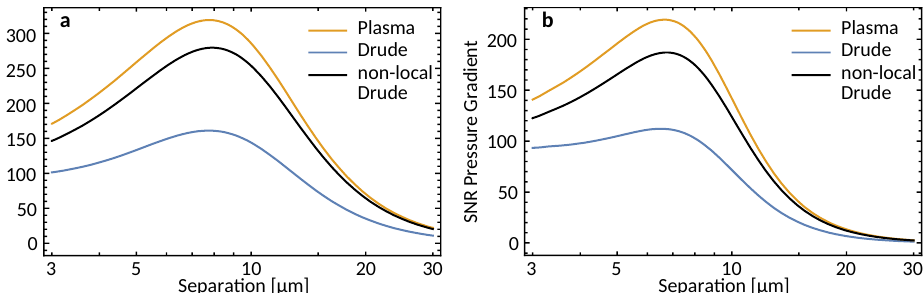
Figure 9. Casimir pressure ( a ) and pressure gradient ( b ) in units of the experimental error. Curves have been computed as described in Section 3 for two gold semispaces using either the Drude model or plasma model to extrapolate tabulated optical data to zero frequency, or the non-local Drude model without consideration of optical data